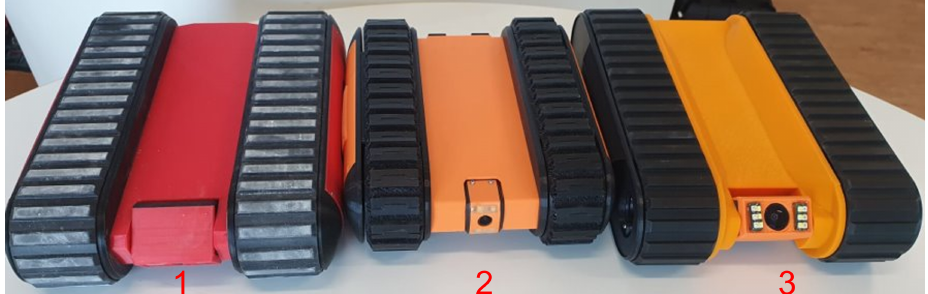
Figure 2. Different Version of Falcon Robot (Version 1, 2 and 3).